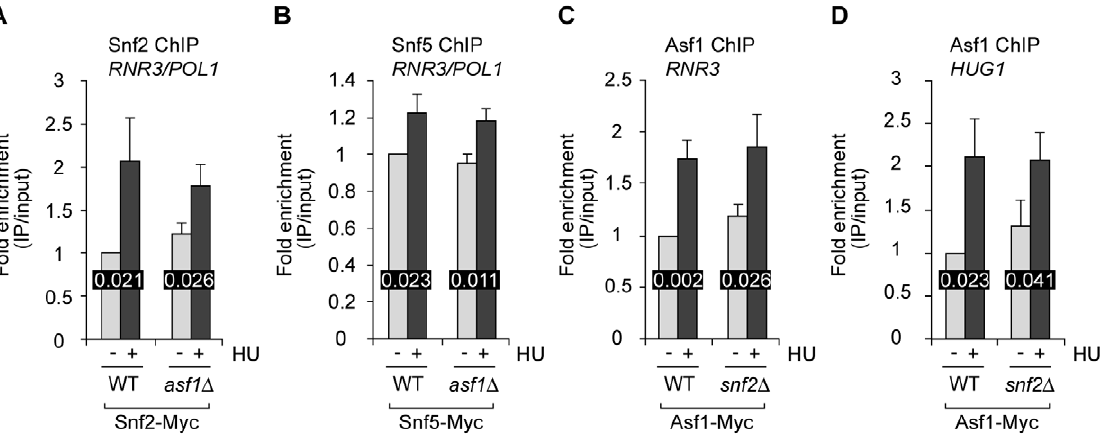
Figure 2. Asf1 and SWI/SNF are both recruited to the promoters of DDR genes during replication stress. A. ChIP analysis of Snf2 recruitment to the promoter of RNR3 in response to HU. In this and all other panels of Figure 2, P values obtained by statistical analysis (Student’s t- test) are shown for comparisons of HU-treated and untreated cells. B. ChIP analysis of Snf5 recruitment to the promoter of RNR3 in response to HU. In A and B, normalization takes into account SWI/SNF subunit cross-linking in the ORF of POL1 ; occupancy in untreated wild type cells is set to 1. C, D. ChIP analysis of Asf1 recruitment to the promoters of DDR genes. Immunoprecipitated DNA was normalised to input DNA and the signal obtained in untreated wild type cells was set to 1. In A-D HU treatment was for one hour. All PCR reactions were performed in triplicate to obtain the data points reported in the graphs.